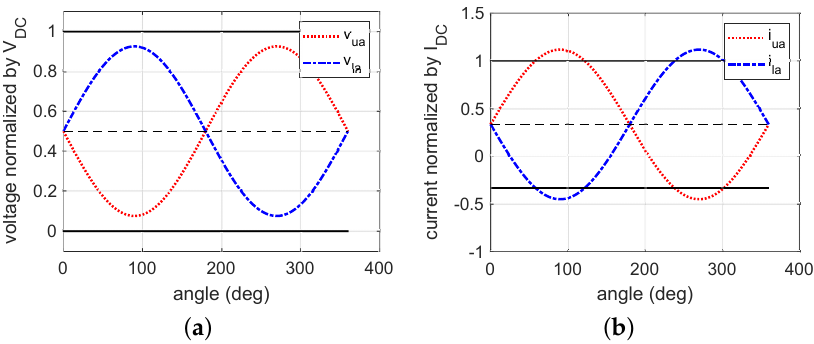
Figure 3. Arm-voltages and arm-currents of MMC with half-bridge cells. ( a ) Voltages. ( b ) Currents.